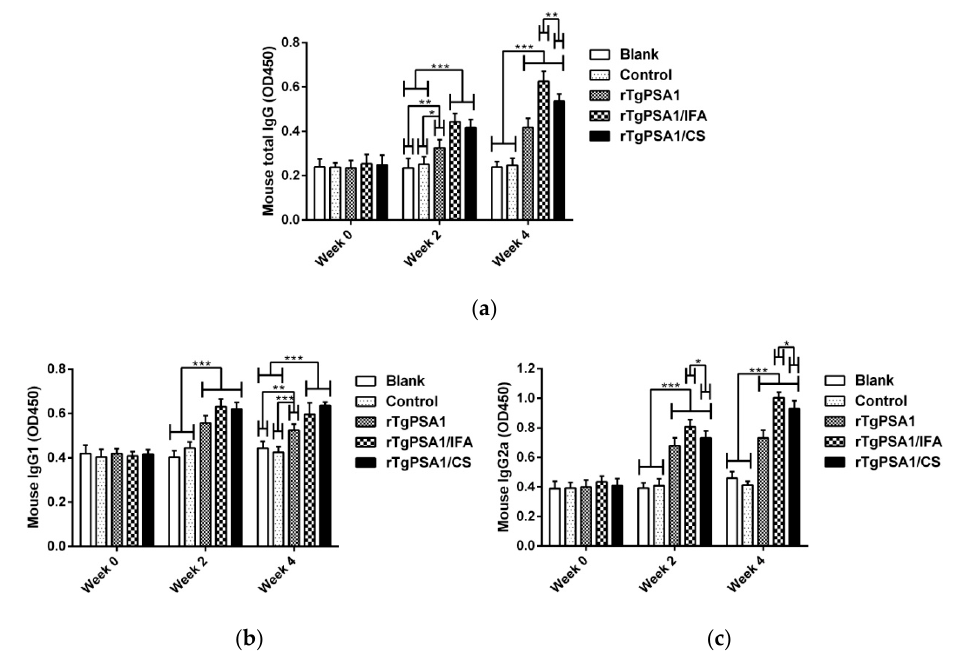
Figure 4. Antibody determination of ( a ) total IgG and isotypes ( b ) IgG1 and ( c ) IgG2 in sera from immunized mice at weeks zero, two, and four. Each sample was conducted once. Values were estimated using one-way ANOVA followed by Dunnett’s test and shown as mean of OD450 ± SD (n = 5). Values between rTgPSA1/IFA and rTgPSA1/CS groups were compared with the independent t -test. * p < 0.05, ** p < 0.01, and *** p < 0.001 compared with blank or control group.